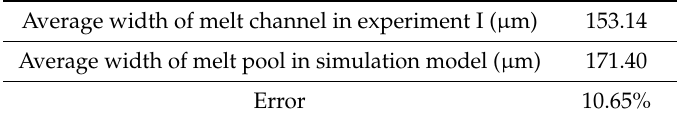
Figure 14. Multi-channel scan experiment at P = 100 W. Table 5. Comparison between average width in experiment I and the model melt-pool width.